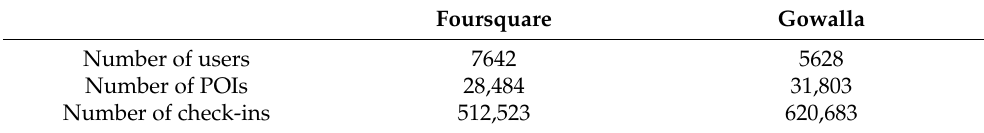
Table 2. Statistics of two